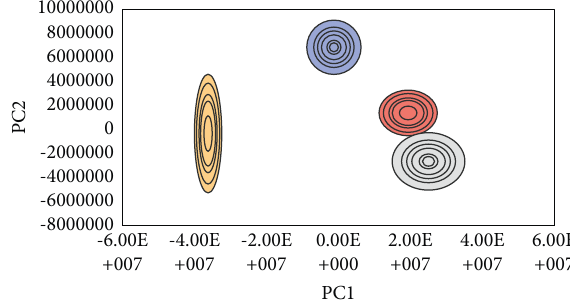
Figure 2: The result of region division of English semantic in- formation cloud drop based on